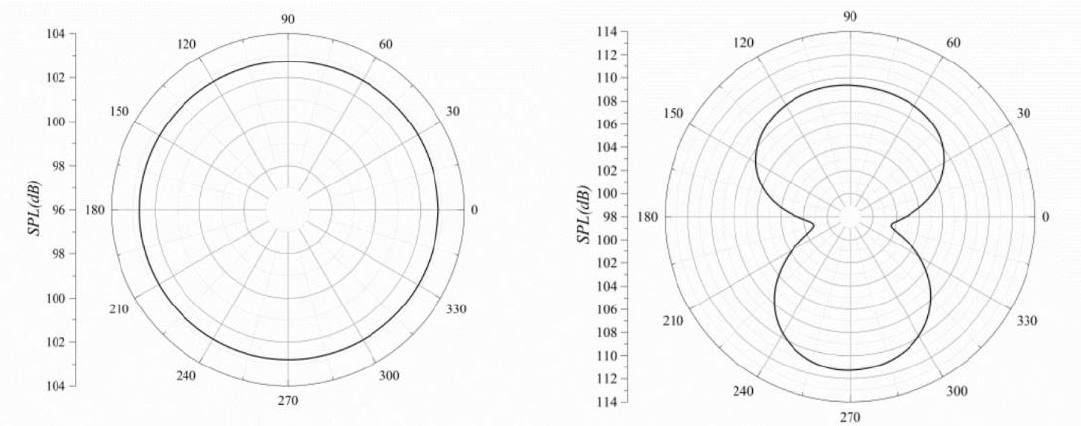
Figure 15. Sound-field leaf frequency directivity of the circumferential and axial polar field. With regard to noise-reduction technology, Huang et al. [81] eliminated the tip clear- ance for the reduction of underwater radiated noise of pump-jets through the SUBOFF model. The results were compared with a pump-jet with 2 mm tip clearance to conclude that this approach effectually suppresses the sound radiation power level. Especially in the lower frequency range, the sound radiation power shows a lower level owing to the great suppression of rotor contribution. In addition, Yu et al. [82] and Denghui et al. [83] installed the sawtooth duct on the post-swirl pump-jet, with the geometry of the pump-jet with a sawtooth duct as shown in Figure 16. The results indicate that with the set of the serrated trailing edge, the vortex intensity is greatly reduced, with a directional noise-reduction effect and a reduced vortex intensity, with circumferential continuity weakening, which can reduce the radial force fluctuation and noise radiation of the duct. Meanwhile, the axial sound-pressure level of the low-frequency noise is reduced significantly. Therefore, the sawtooth duct, which has excellent noise reduction at low frequencies, is an effective approach to reduce radiated noise of pump-jets with minimal influence on the hydrody- namic performance.